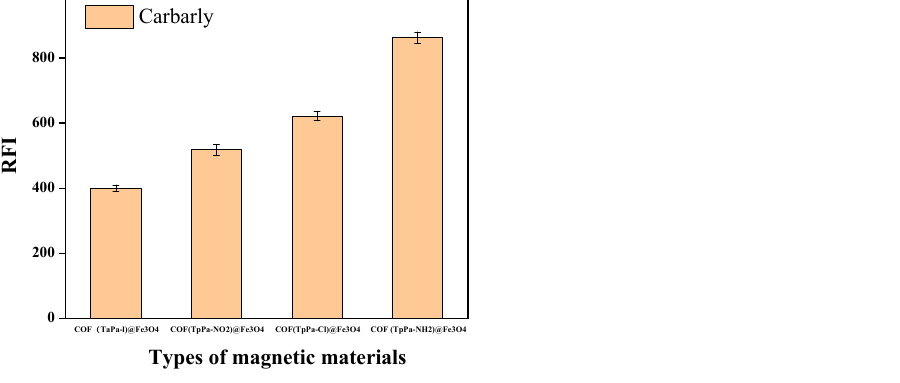
Figure 1. Selection of magnetic material. To conclude, COF (TpPa-NH 2 ) @Fe 3 O 4 was the best extract- ant (50 mL of sample solution, c = 100 ng·mL − 1 , extraction time: 5 min, desorption time: 6min, n = 3).